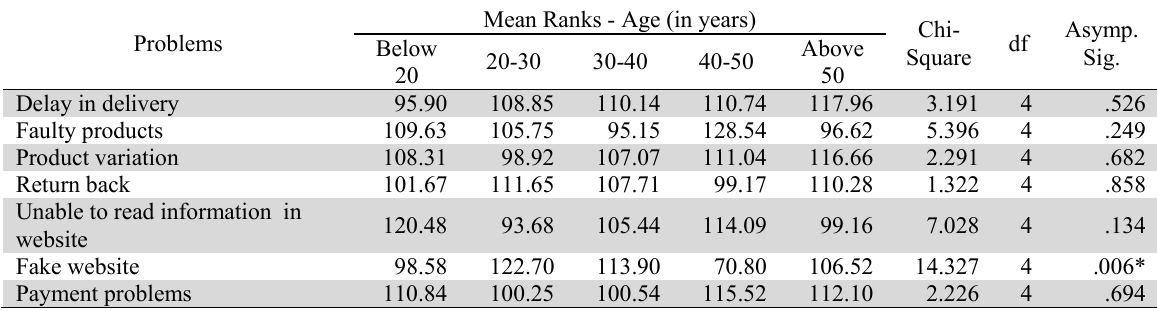
Results of Kruskal Wallis Test - Age Vs Ranking of Problems